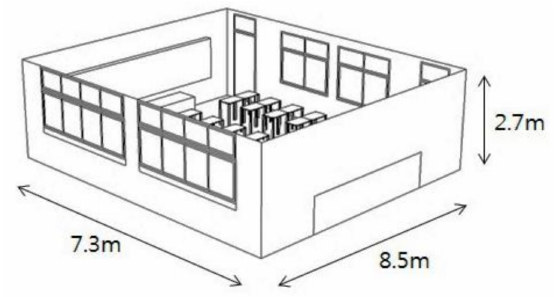
Figure 4. Standard model of Korean classrooms.